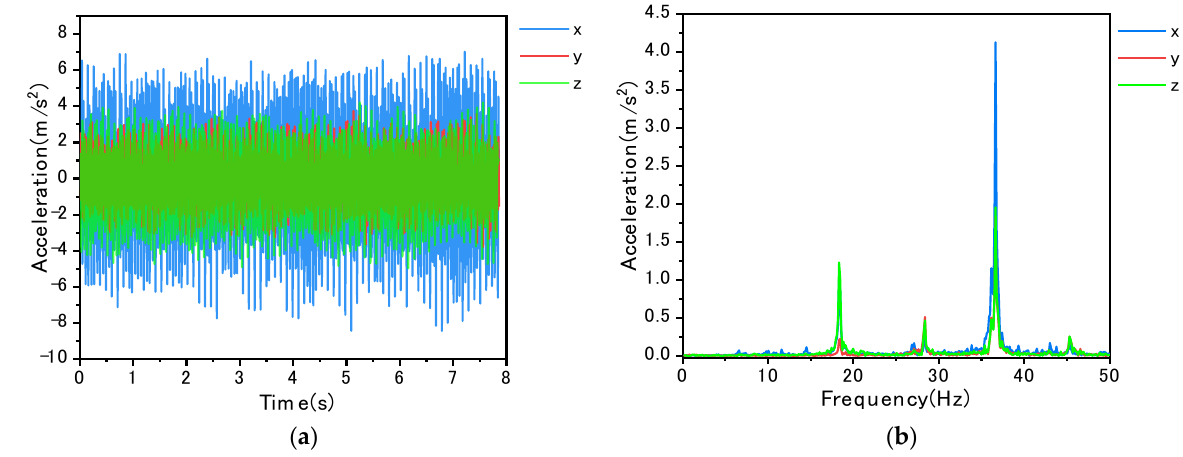
Figure 8. Results of static no-load test for the walking protection frame of the chipper tractor: ( a ) time – frequency diagram; ( b ) amplitude – frequency diagram.